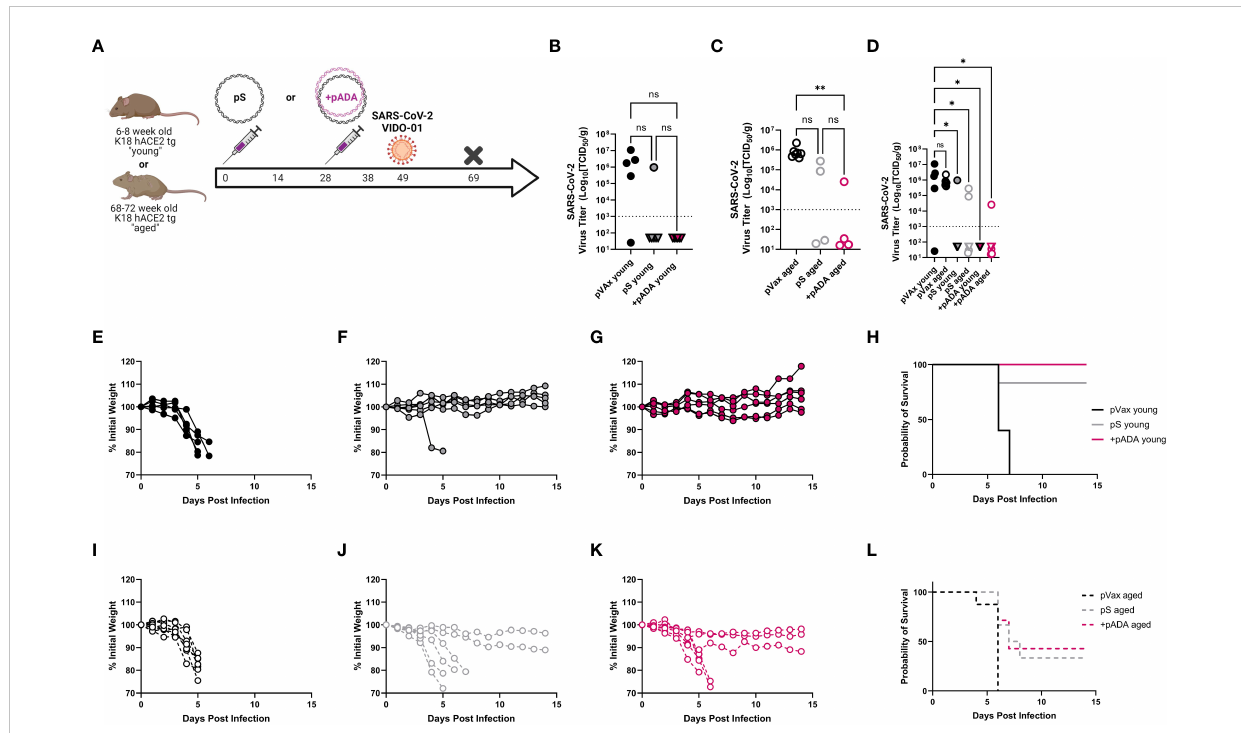
FIGURE 5 pADA co-immunization supports protection in a human ACE2tg aging mouse SARS-CoV-2 challenge model. Young (6-12 week-old) or aged (52-68 week-old) human ACE2 transgenic mice were immunized twice as in Figure 2 and challenged with 1x10 5 plaque-forming units of SARS-CoV-2 (VIDO-01) on day 19 post-challenge and morbidity and mortality were monitored until day 15 post-challenge (A) . SARS-CoV-2 lung viral loads as measured by TCID50 assay among young (B) , aged (C) , and (D) all mice including survivors(triangles) and non-survivors (circles). Weight loss among empty-plasmid (pVax) (E) , pS-only (F) , and pADA co-immunized (G) young animals, and overall survival among young animals (H) . Weight loss among empty-plasmid (pVax) (I) , pS-only (J) , and pADA co-immunized (K) aged animals, and overall survival among aged animals (L) . Symbols represent the mean of triplicate assays for individual animals (B – D) or weights of individual animals (E – G, I – K) . Lines represent the group probability of survival (H, L) . ns, not signi fi cant. *P<0.05 and **P<0.01, by Kruskal-Walis